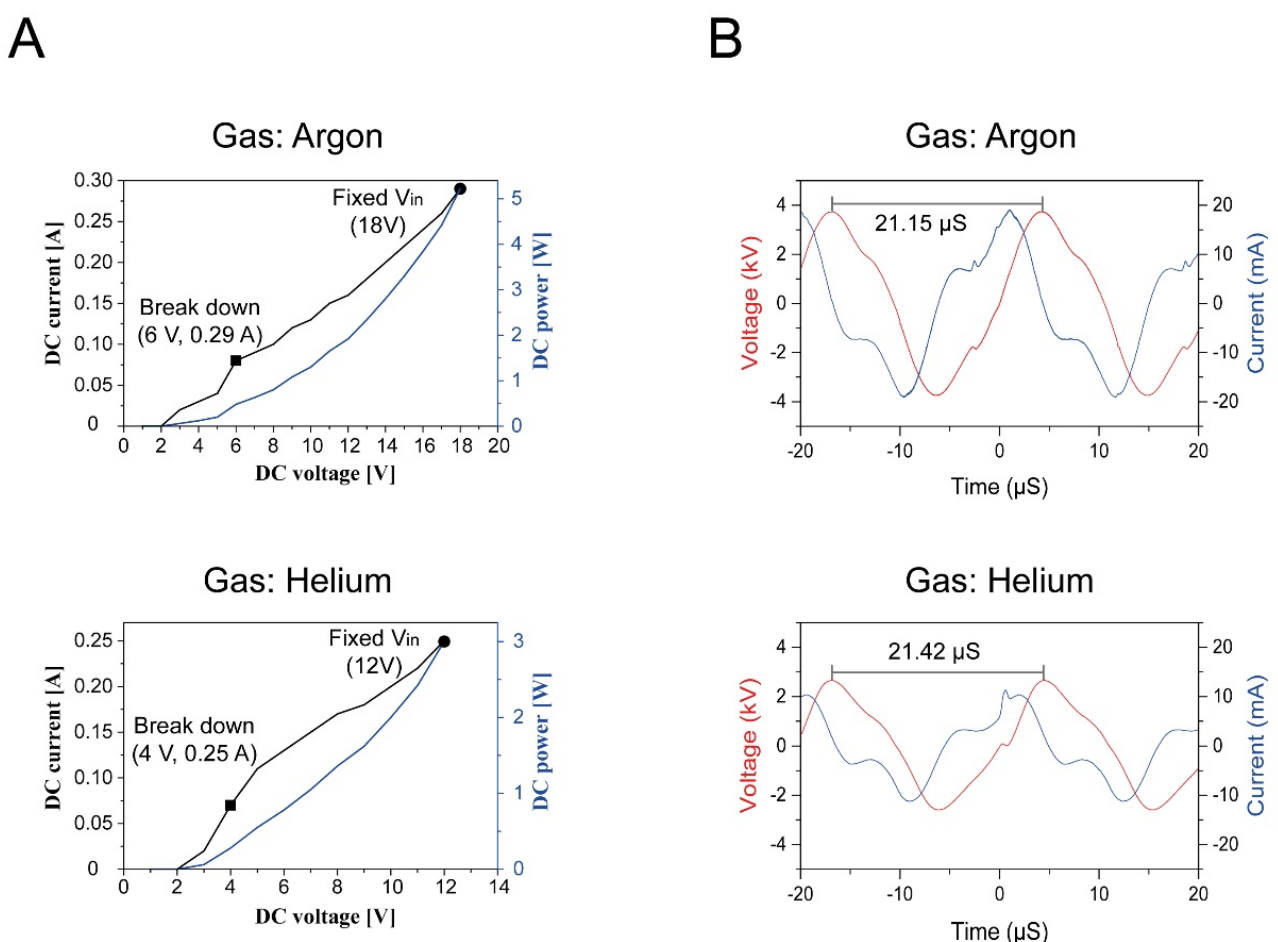
Figure 2. IV curve and electrical waveform of argon and helium plasma jets. The gas flow rates of argon and helium were fixed at 2 slm. ( A ) DC input voltage and DC Discharged current for argon and helium plasma. The breakdown voltage were 6 V for argon and 4 V for helium, The DC input voltage for transdermal permeability experiment were fixed 18 V and 12 V in argon and helium gas, respectively. ( B ) Waveforms of the inverted AC applied voltage and discharge current for the argon and helium plasma at DC input voltage 18 V and 12 V, respectively. The applied RMS voltages were 2.54 kV for argon and 1.73 kV for helium, and their RMS discharge currents were 11.01 mA and 6.21 mA, respectively.